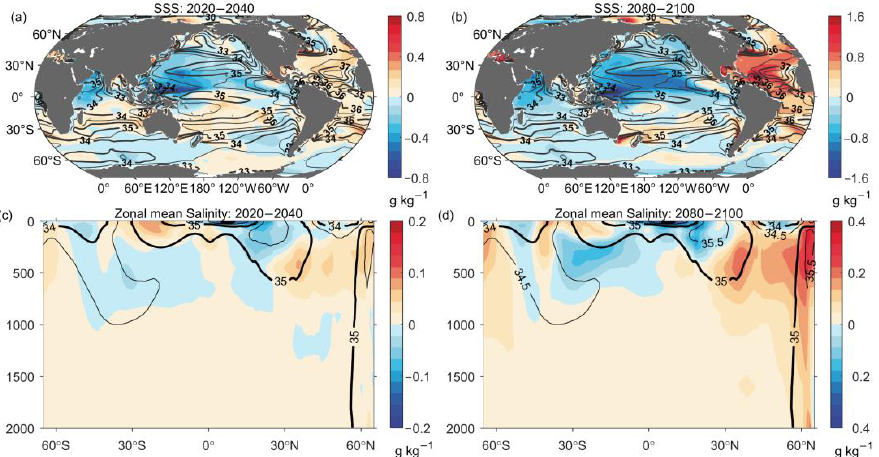
Figure 8. Projection of spatial patterns of period differences of sea surface salinity (SSS) anomaly (left panels) and global zonal mean of subsurface salinity anomaly from the surface to 2000 m (right panels) for CAS-ESM2-0 model under SSP5-8.5 between the period of 2020 – 2040 ( a , c ), 2080 – 2100 ( b , d ), and 1960 – 1980. The black contours denote CAS-ESM2-0 historical climatology averaged be- tween 1990 – 2010. Anomalies are the period ’s mean values relative to the 1990 – 2010 baseline period.